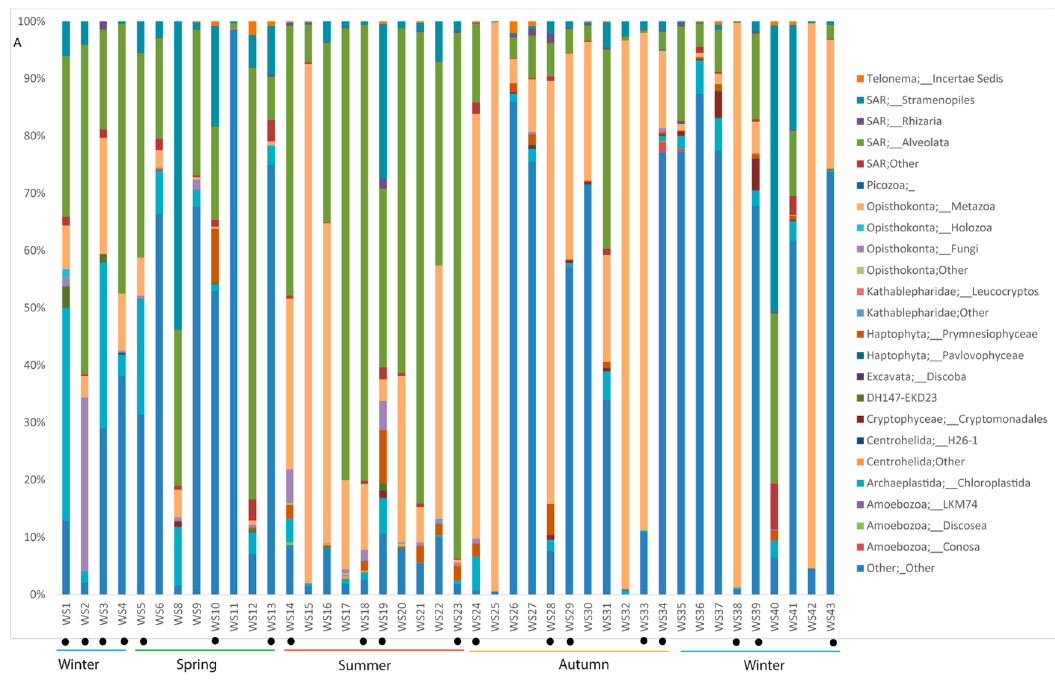
Figure 5. Chao1 indices of the alpha diversity of sequence reads WS1–WS42 corresponding to WaMS samples from 2011–2012. Sequence reads are shown on the vertical axis, with Chao1 diversity values on the horizontal axis.